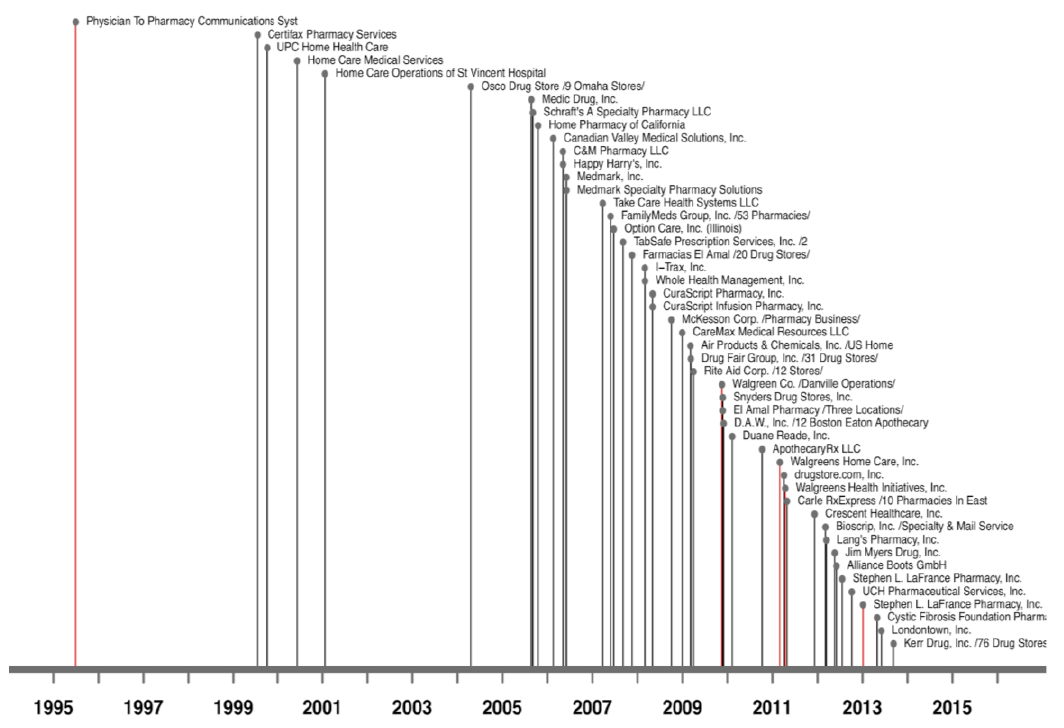
Figure 4: Acquisitions (black lines) and divestitures (red lines) - Walgreens (1993–